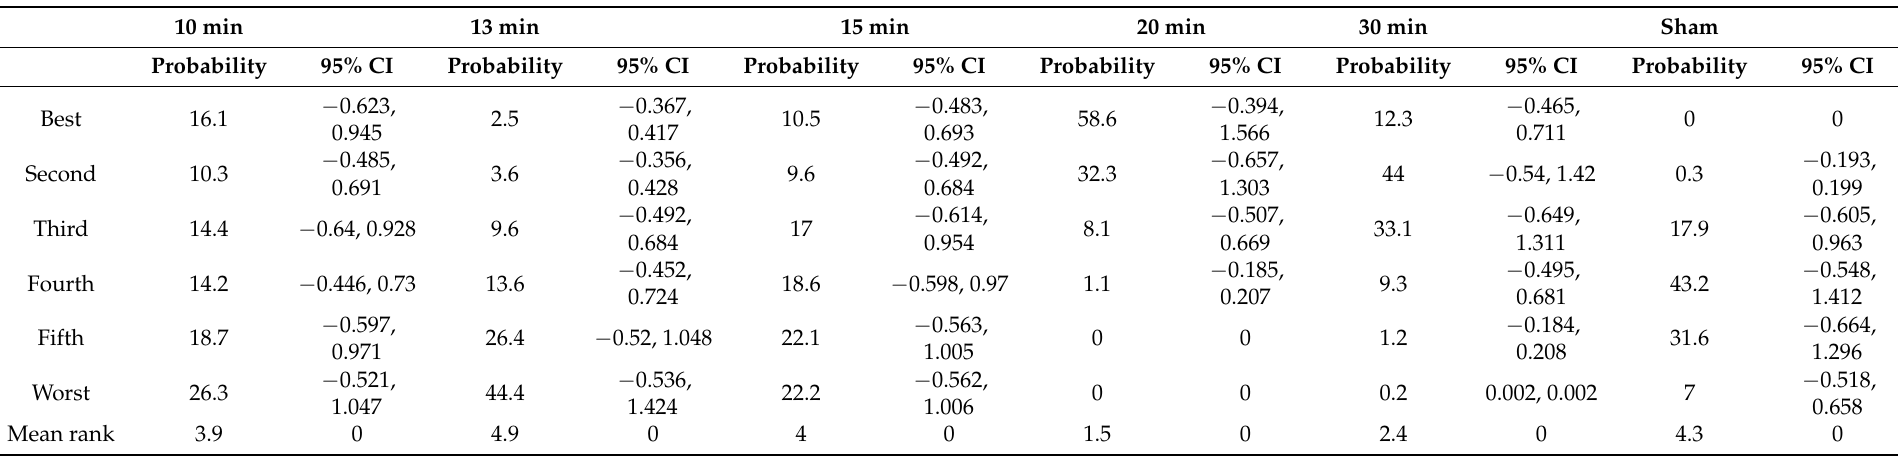
Table 4. Results: network meta-analysis session